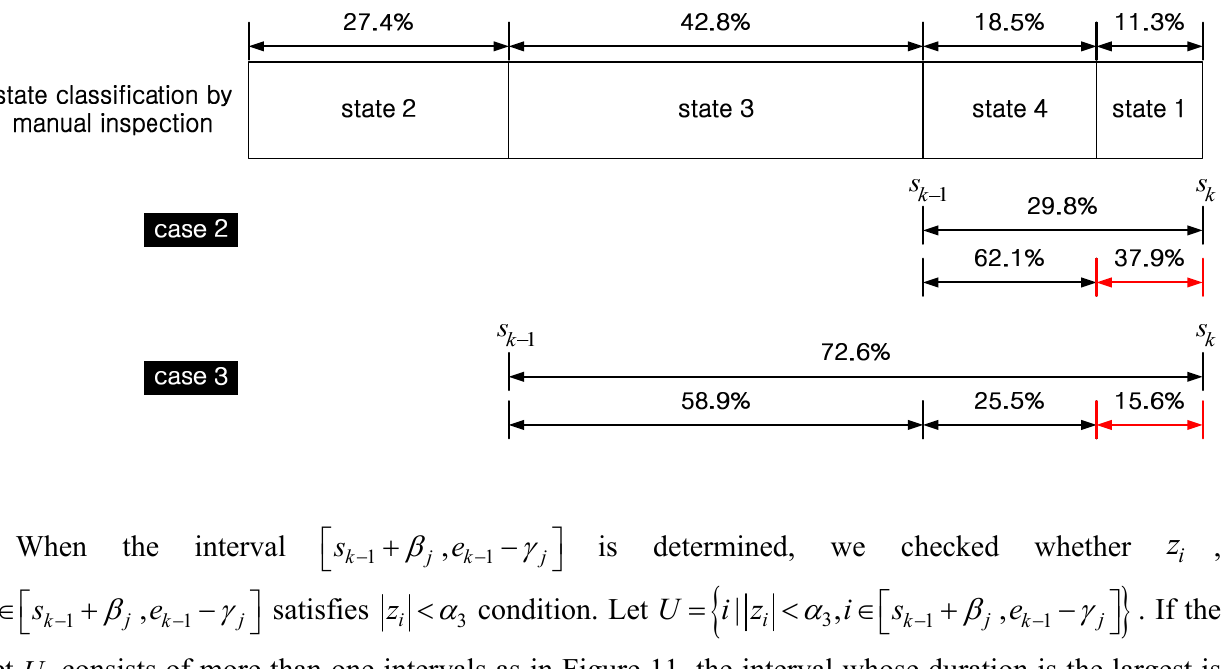
Figure 10. Average duration ratio of each state by manual inspection and its use in Case 2 and